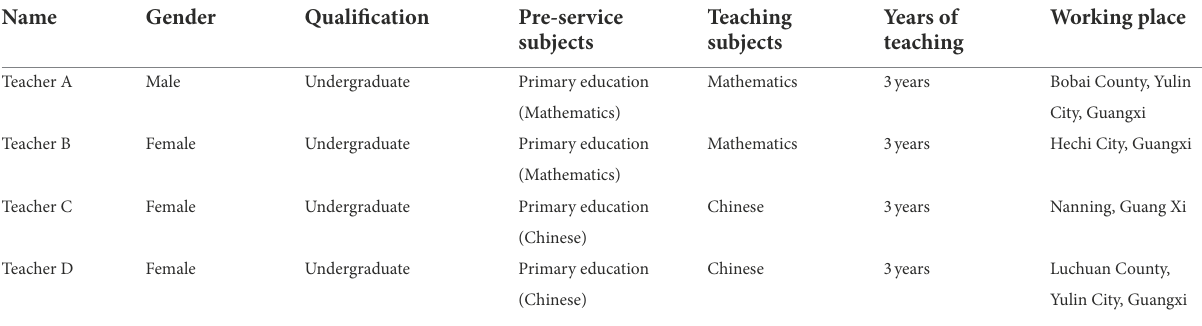
TABLE 1 Basic information of comprehensive